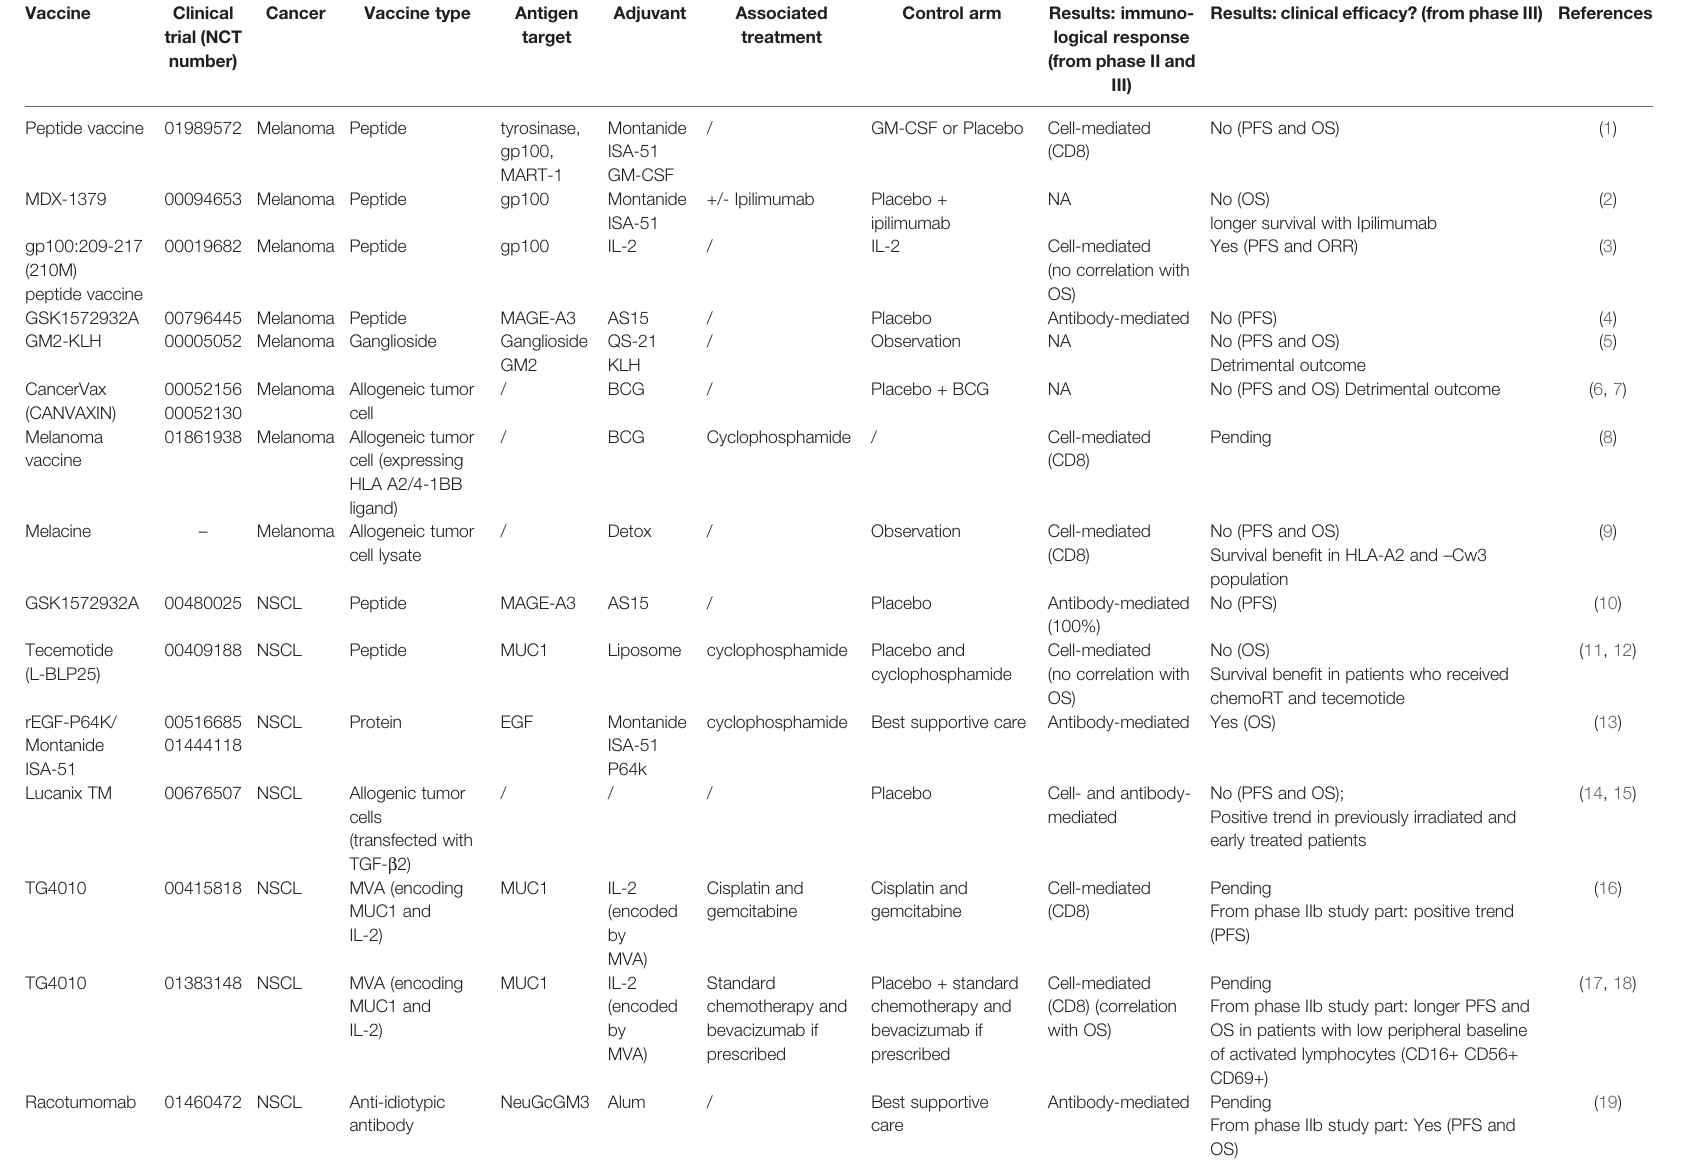
TABLE 1 | Completed phase 3 cancer vaccine